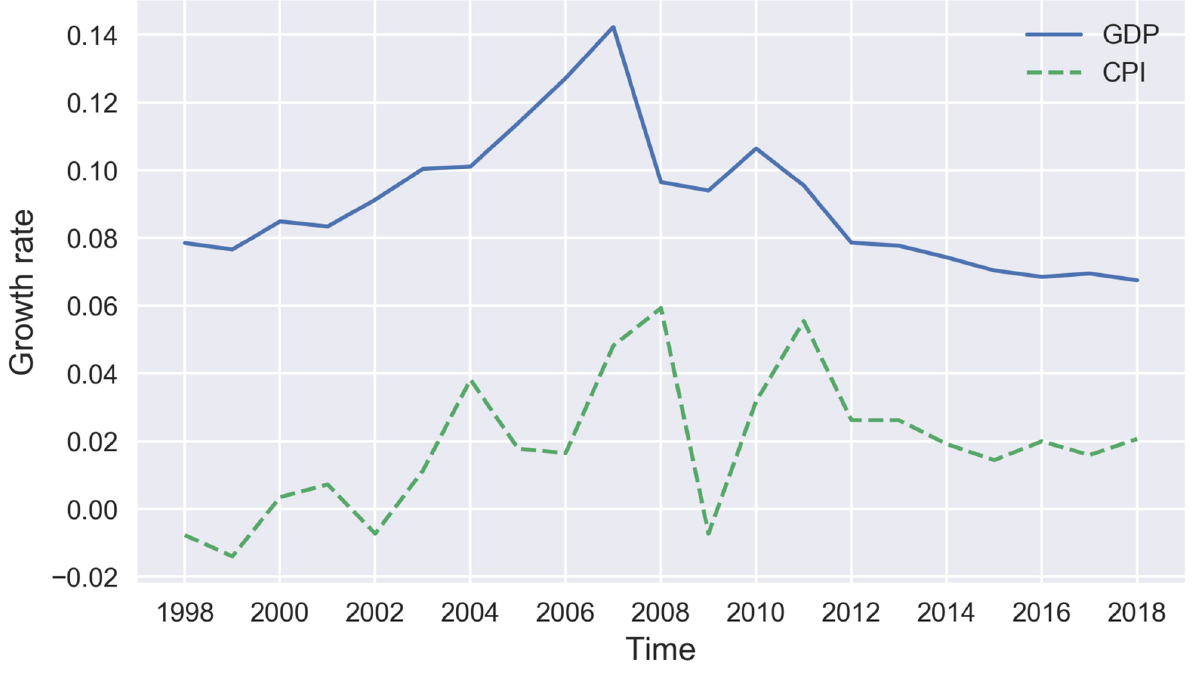
Fig 5. The trend of GDP year-on-year growth rate and CPI year-on-year growth rate.